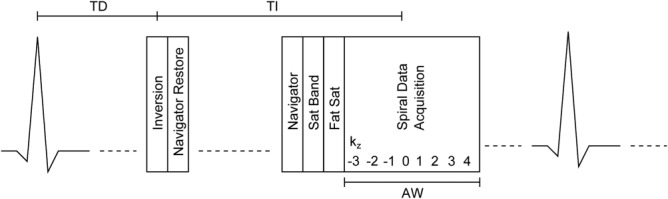
Sequence timing of the navigator 3D spiral sequence showing one RR interval. The adiabatic inversion pulse is played out at delay time (TD) such that imaging is performed in the diastolic rest period. A navigator restore (selective inversion pulse) immediately follows to reinvert signal for the navigator, which is performed prior to a spatial saturation band, positioned over the chest wall and the chemical shift saturation pulse for fat signal. The imaging block is played out such that the acquisition of kz = 0 is at the inversion time TI. All 8 kz encoding steps for one of 16 spiral interleaves are acquired on alternate RR intervals with data acquisition window of 102.4 msec.